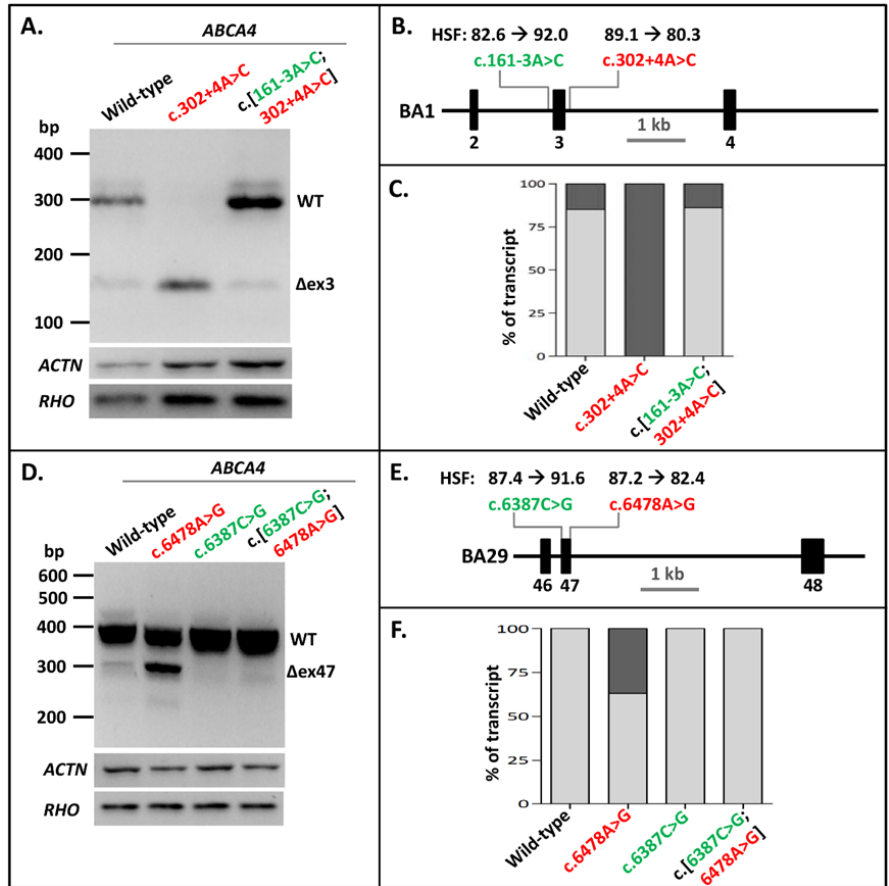
Figure 3. Strengthening 3′ splice sites rescues splice defects due to pathogenic 5′-splice-site variants